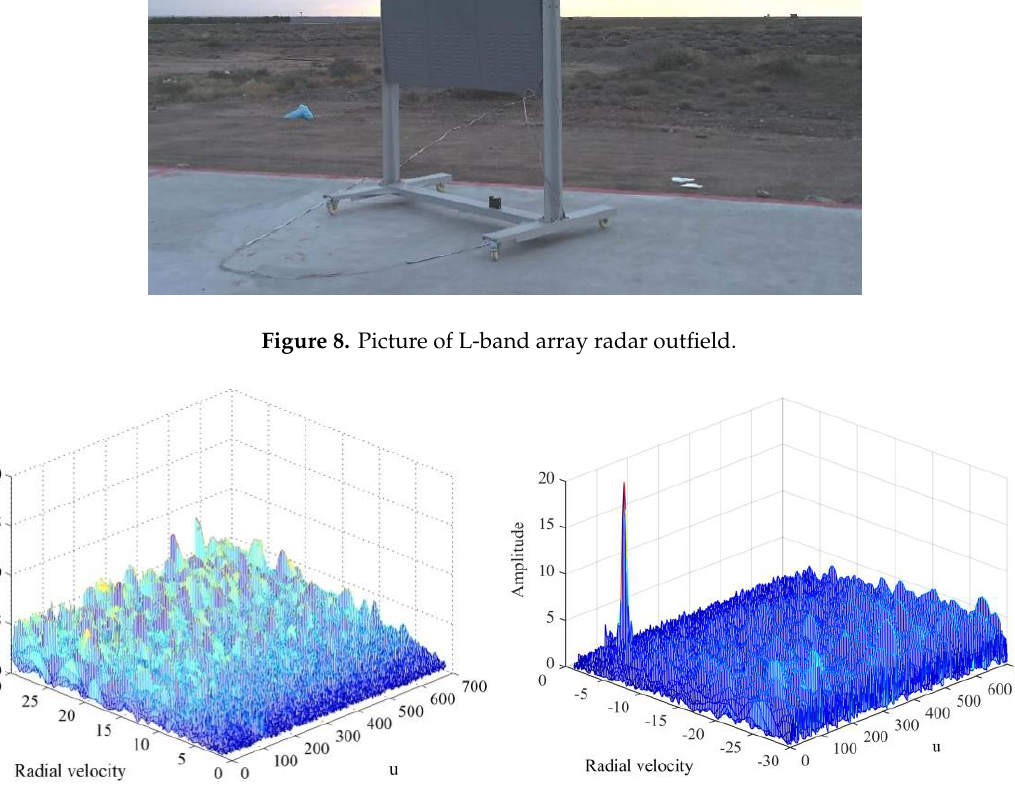
( a ) ( b ) Figure 10. MTD algorithm applied to unmanned aerial vehicles (UAV) detection. ( a ) Range-Doppler plane without cancelling fixed objects; ( b ) range-Doppler plane with a true target and several false alarms after eliminating zero frequency and four adjacent frequencies. Figure 9a shows that there is no peak resulting from phase compensation and coherent accumulation of the positive velocity, indicating the absence of targets in the positive velocity region. Figure 9b shows an effective peak from the negative velocity processing, indicating the presence of the UAV at coordinates (91, −4.6, 19.94) with an estimated velocity of